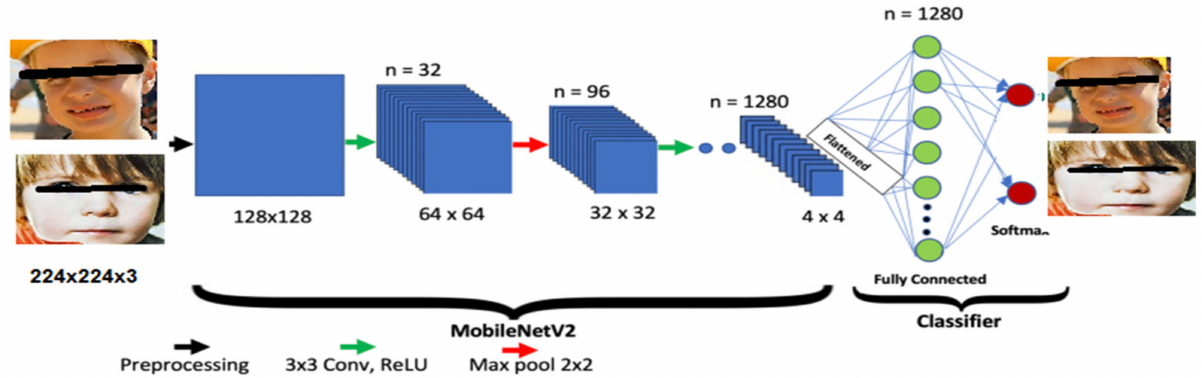
Figure 7. MobileNet’s